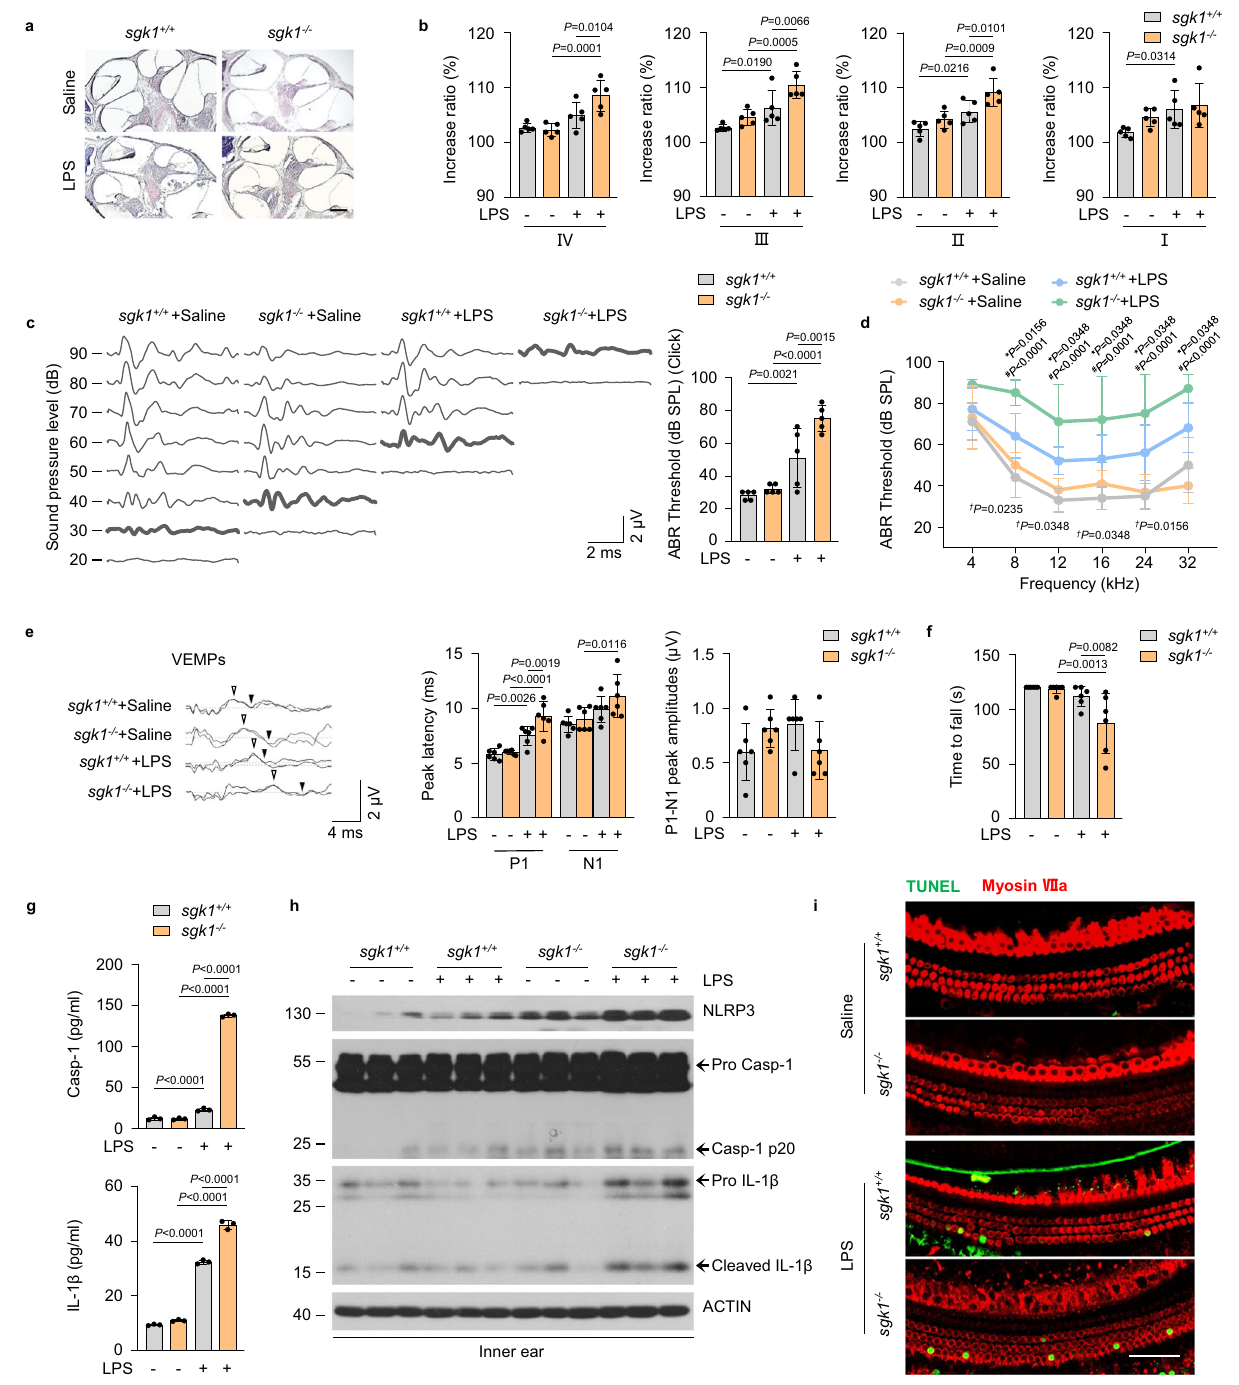
Fig. 5 | SGK1 de fi ciency exacerbated the severity of LPS-induced EH and audiovestibular symptoms in vivo. a – i sgk1 +/+ and sgk1 − / − mice were treated with LPSorsaline. a Representativeimagesofmid-modiolarcochlearsections,scalebar= 200 μ m. b Measurements of IR-L in cochlear half-turns I – IV ( n =5 mice per group). c Representative serial ABR wave recordings and thresholds in response to click sounds ( n =5 mice per group). d ABR thresholds in response to pure tone bursts across all frequencies tested (4, 8, 12, 16, 24, and 32kHz) ( n =5 mice per group). * P indicates p -values for sgk1 +/+ +LPS versus sgk1 − / − +LPS; # P indicates p -values for sgk1 − / − +LPS versus sgk1 − / − +Saline; † P indicates p -values for sgk1 +/+ +LPS versus sgk1 +/+ +Saline. e Representativeclick-evokedVEMPswaves,P1-N1peakamplitudes,andthe P1 (white triangle) and N1 (black triangle) peak latencies of VEMPs at 100dB nHL